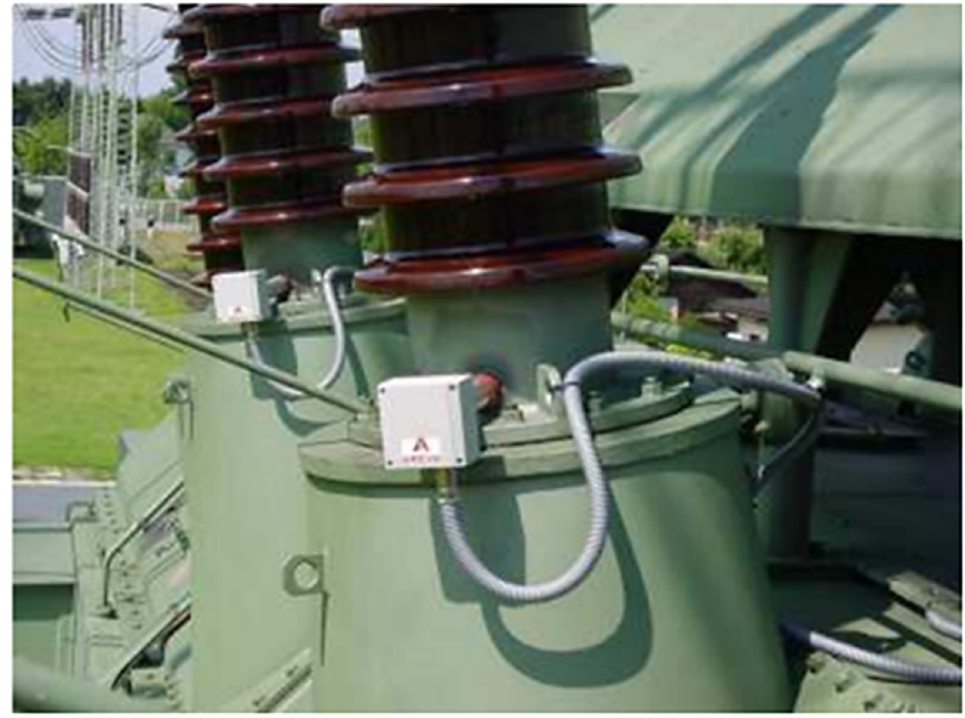
Figure 18. Crossing monitoring sensor [65].